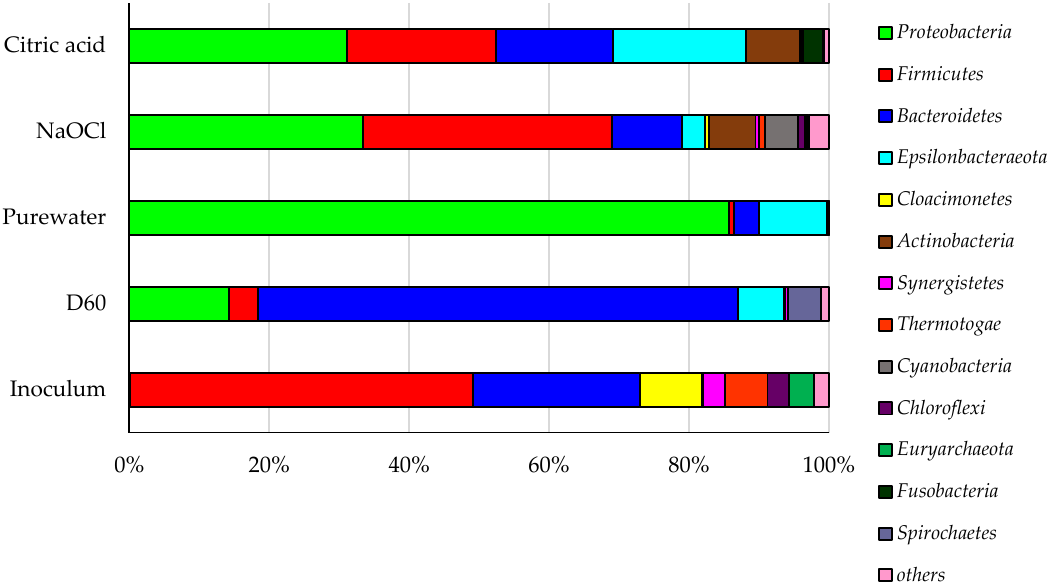
Figure 5. Community bar plot analysis at phylum level for cleaning solution and anaerobic sludge.